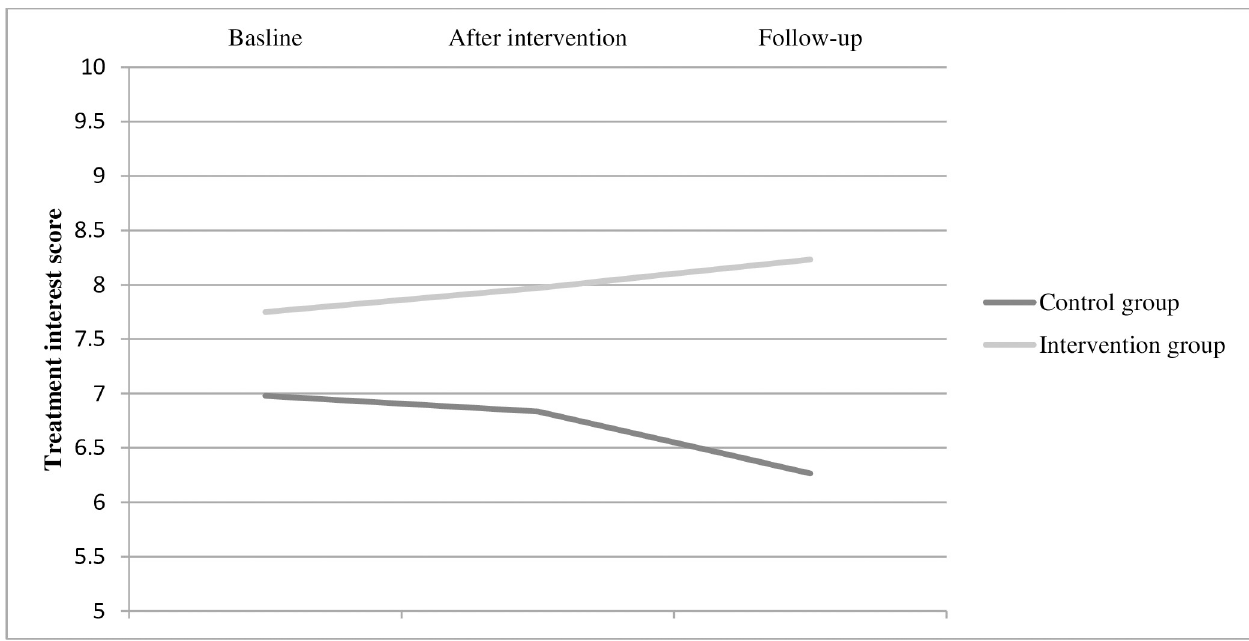
Fig 4. Mean scores for each group on interest in other treatment programmes at each time